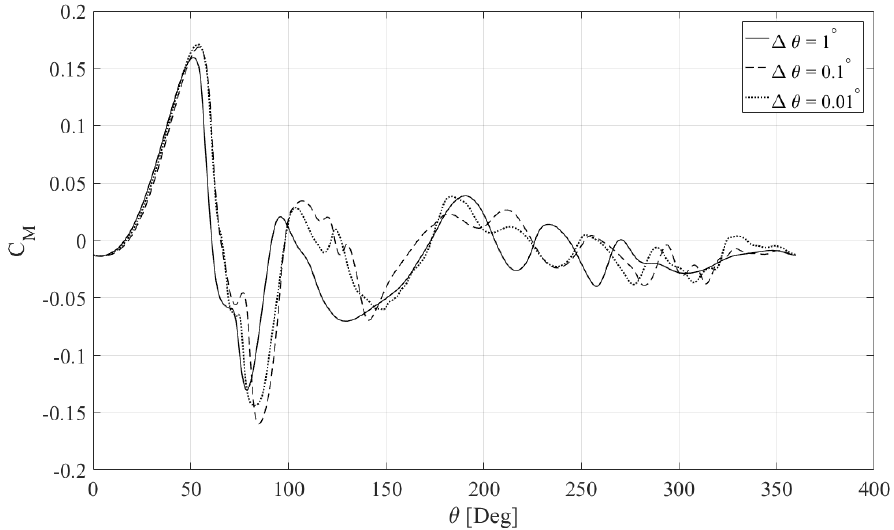
Figure 13. Temporal independence.